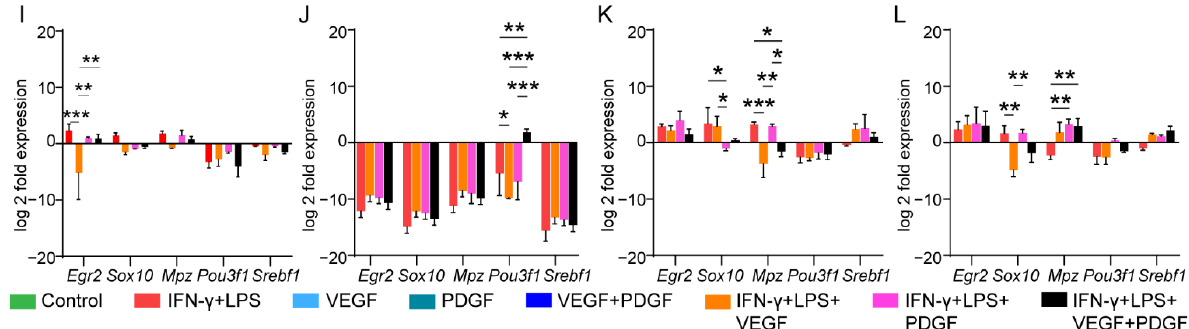
Figure 5. Effect of unconditioned and macrophage conditioned media (MCM) with or without VEGF, PDGF on myelination associated gene expression in primary OECs. ( A – L ) Graphs represent the log 2-fold expression of genes responsible for myelination in OECs when treated with unconditioned media (No MCM), 3 h, 24 h and 48 h MCM. ( A – D ) Untreated control and IFN- γ + LPS media for ( A ) Unconditioned media, ( B ) 3 h MCM, ( C ) 24 h MCM, ( D ) 48 h MCM ; ( E – H ) Untreated control vs. VEGF vs. PDGF vs. combined VEGF + PDGF ( E ) Unconditioned media, ( F ) 3 h MCM, ( G ) 24 h MCM, ( H ) 48 h MCM; ( I – L ) IFN- γ + LPS vs. IFN- γ + LPS + VEGF vs. IFN- γ + LPS